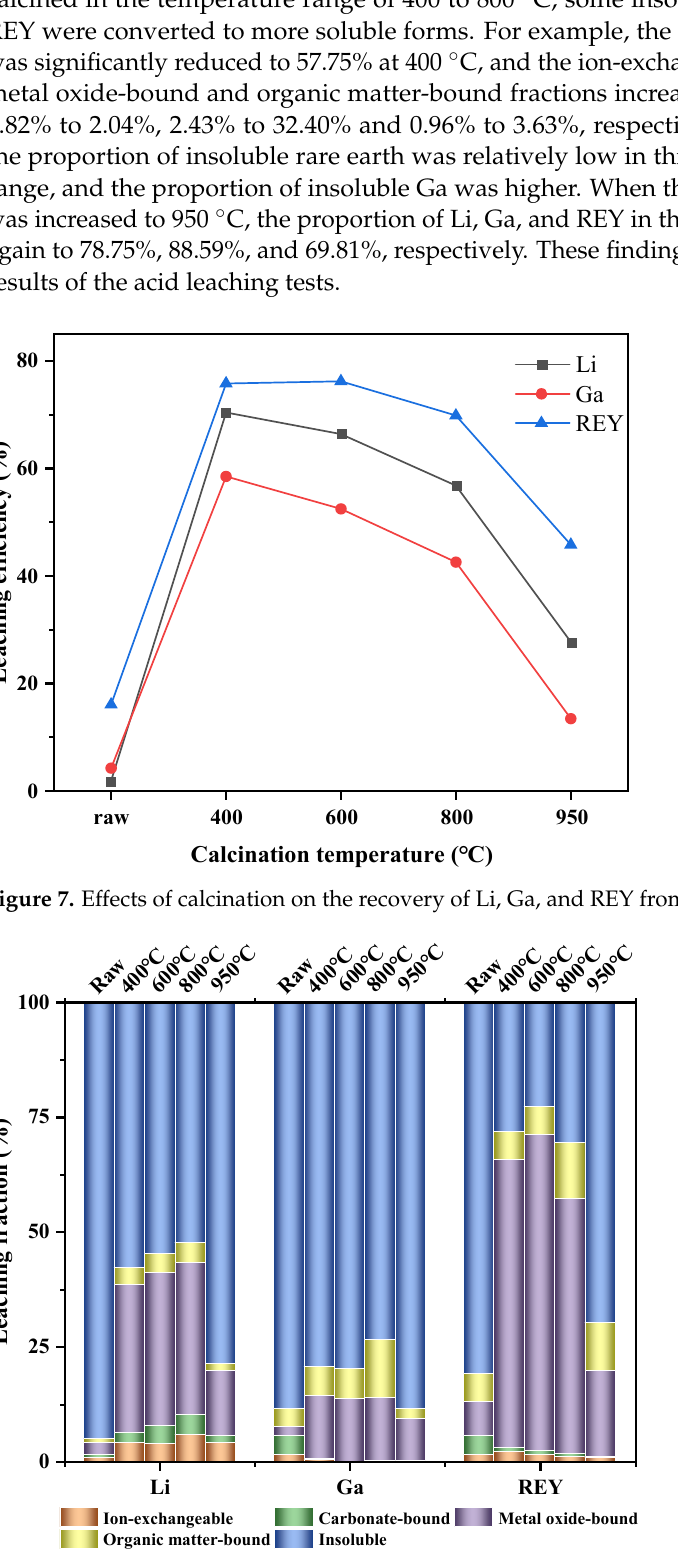
Figure 8. The distribution of Li, Ga, and REY in different modes of occurrence in raw and calcined coal gangues.